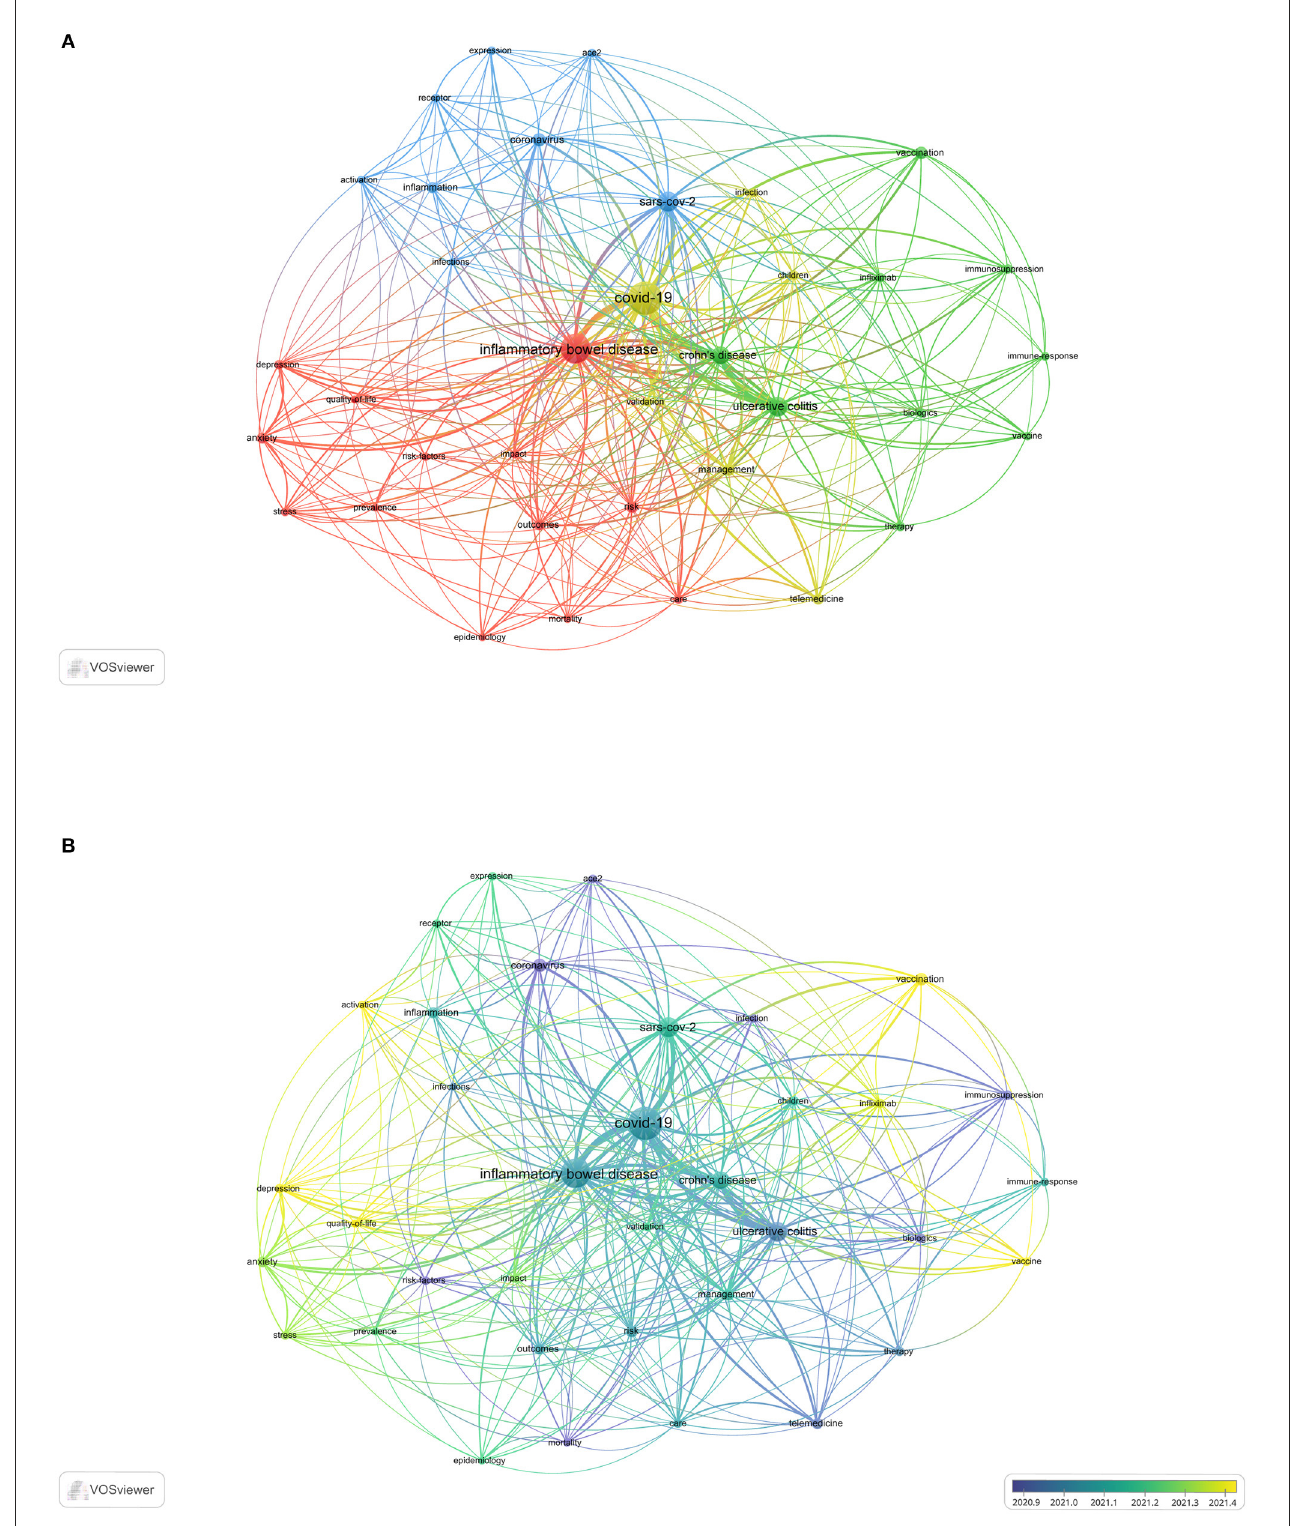
FIGURE5 The co-occurring keywords in the field of IBD and COVID-19. (A) High-frequency keywords. (B) Time sequence chart of keyword